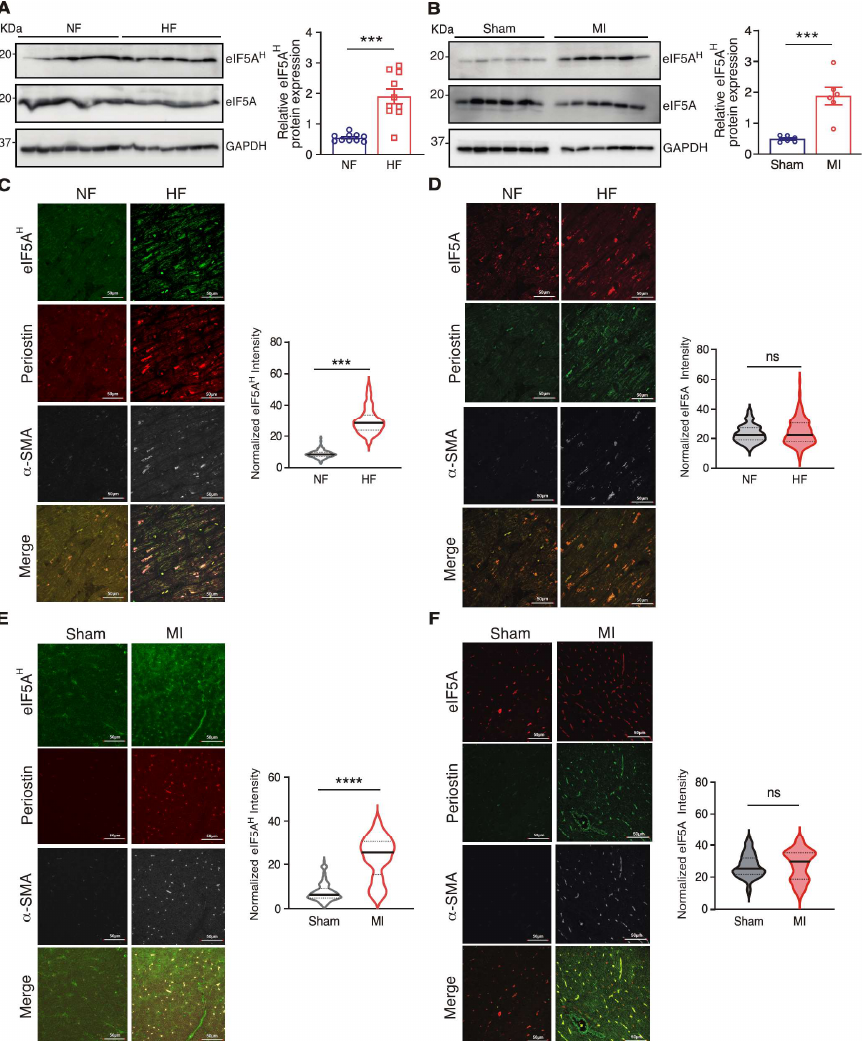
Figure 1. Induced eIF5A H protein expression is associated with human and mouse heart failure. ( A ) eIF5A H protein was increased in failing human hearts ( n = 10) compared to non-failing donor hearts ( n = 10). GAPDH was used as a loading control for quantification. ( B ) eIF5A H protein was increased in mouse MI hearts ( n = 6) compared to sham hearts ( n = 6). Quantification of Western blot results from the border zone of the MI heart and the corresponding region of the sham heart was performed. GAPDH was used as a loading control for quantification. ( C , D ) eIF5A H protein was increased in the cardiac fibroblasts of failing human hearts compared to non-failing donor hearts. n = 120 cells were counted from multiple sections from mouse hearts ( n = 10). Scale bar: 10 µ M. Co-staining of Postn and α -SMA was performed. ( E , F ) eIF5A H protein was increased in the cardiac fibroblasts of mouse MI hearts ( n = 6) compared to sham hearts ( n = 6). Scale bar: 10 µ M. *** p < 0.001, **** p < 0.0001, ns: not significant by unpaired two-tailed student t